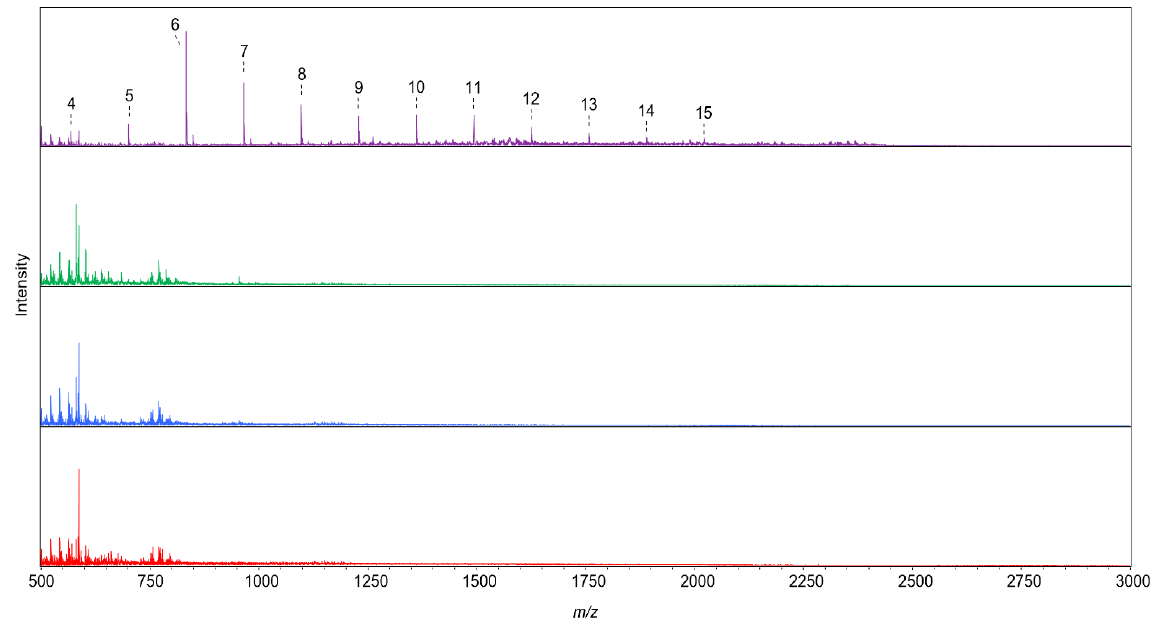
Figure 5. MALDI- TOF mass spectra from AX incubated for 24 h with 50 μg mL −1 Mg ABF51 (red), Po ABF62 (blue), Hi ABF43_36a (green), and Tp ABF43_36b (purple). All detected Na + adducts of pentose oligomers ((A)XOS; DP 4 to 15) were annotated and numbered 4 to 15. No oligosaccharides were detected for the incubations with Mg ABF51, Po ABF62, and Hi ABF43_36a. Reaction conditions are displayed in Section 4.2.2, exp. # 1.